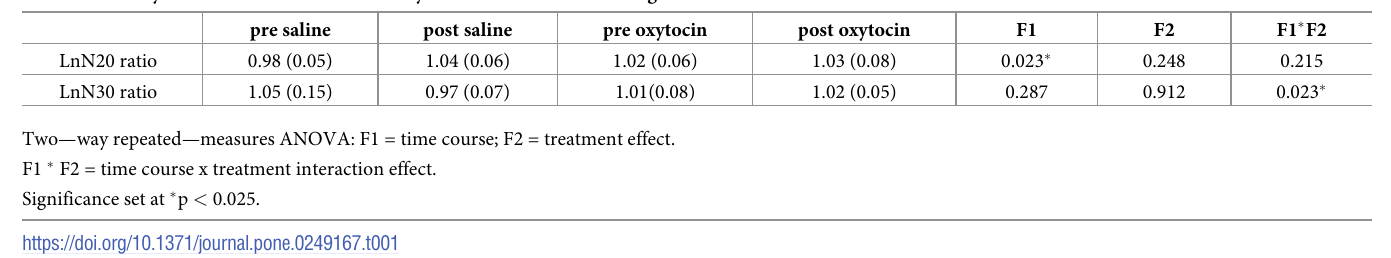
Fig 4A illustrates the grand average of the ITC for all subjects in the bilateral precentral and postcentral gyri during moving and static images observations after saline and oxytocin administration. The N30 component was accompanied by an increase in gamma phase locking in both the precentral and postcentral gyri on the left hemisphere. Paired-sample t-tests failed to identify significant ITC differences in the bilateral precentral and postcentral gyri between moving static image observations after oxytocin administration, when the statistical threshold was set at p < 0.05 with false discovery rate corrections across ROIs, signals, and frequency dimensions (Fig 4B). After saline administration, however beta suppression was observed in the right precentral gyrus, while an enhanced gamma band was